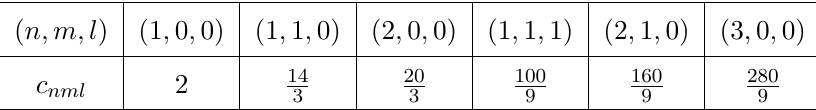
Table 1 . Coe(cid:14)cients of thermal averaged velocity